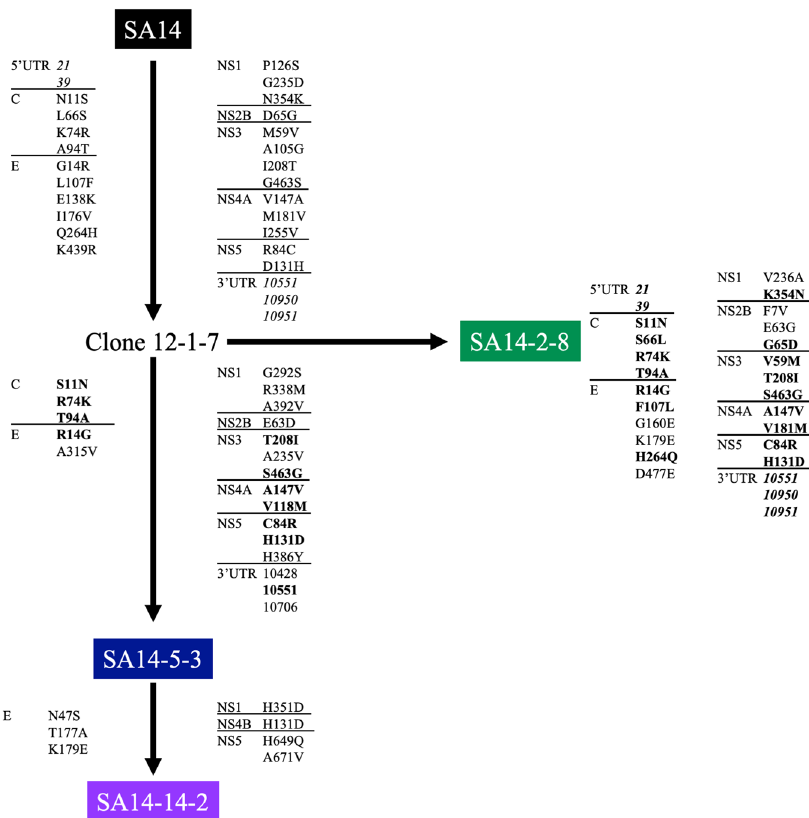
Fig. 2 Consensus changes during JEV vaccine derivation. The complete genomes of SA14, Clone12-1-7, SA14-2-8, SA14-5-3 and SA14-14-2 were compared. Consensus changes that represent a reversion to the parental, WT strain SA14 are bolded. Consensus changes that occur within the protein coding region of the genome are reported as the codon number within the gene. Consensus changes that occur outside the protein coding region are italicized and reported as a nucleotide number. Sequences of SA14, SA14-2-8, SA14-5-3 and SA14-14-2 were generated in house through Illumina sequencing. The sequence for Clone-12-1-7 was accessed from GenBank